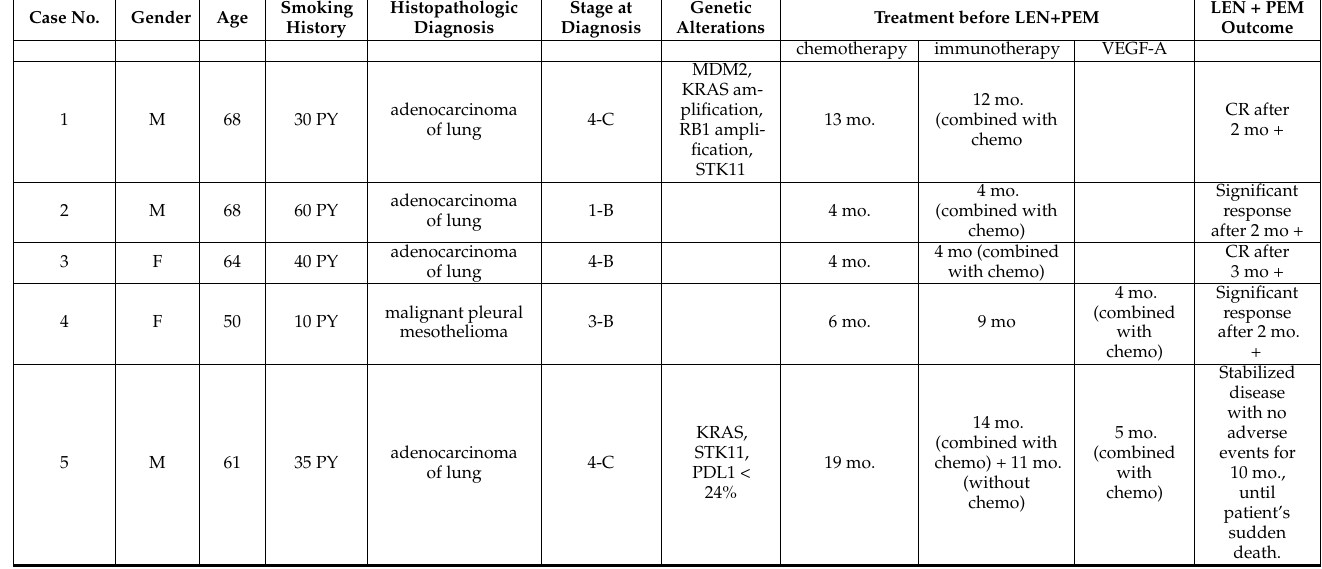
Table 1. Summary of clinical characteristics and treatment outcomes of patients presented in cases 1–5. Case No.